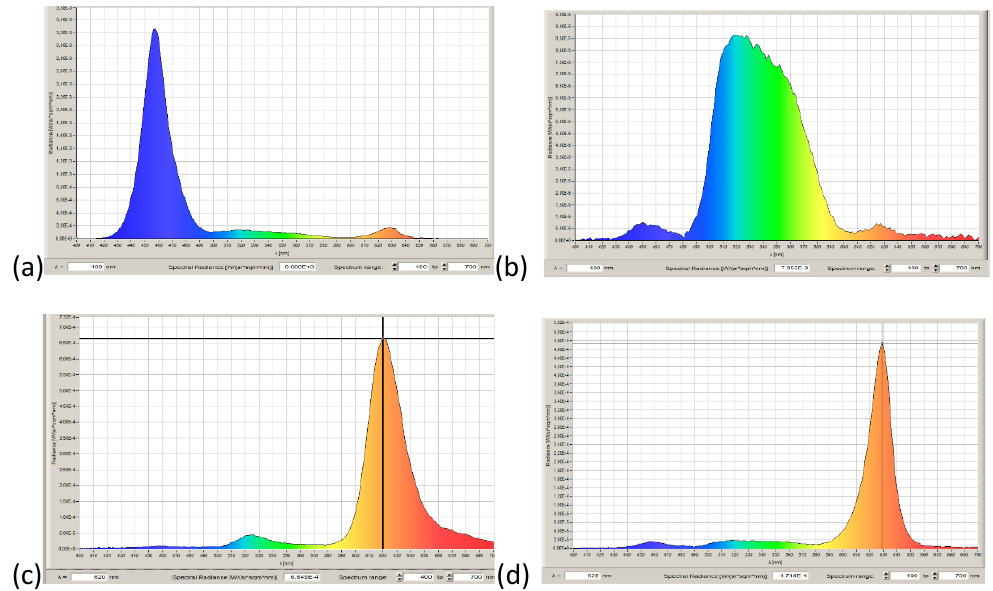
Figure 15. Spectra of the output image. ( a ) λ = 457 nm. ( b ) λ = 520 nm. ( c ) λ = 628 nm (at a temperature equal to 20 ° С). ( d ) Wavelength offset λ = 618 nm (at a temperature equal to 5 ° С).